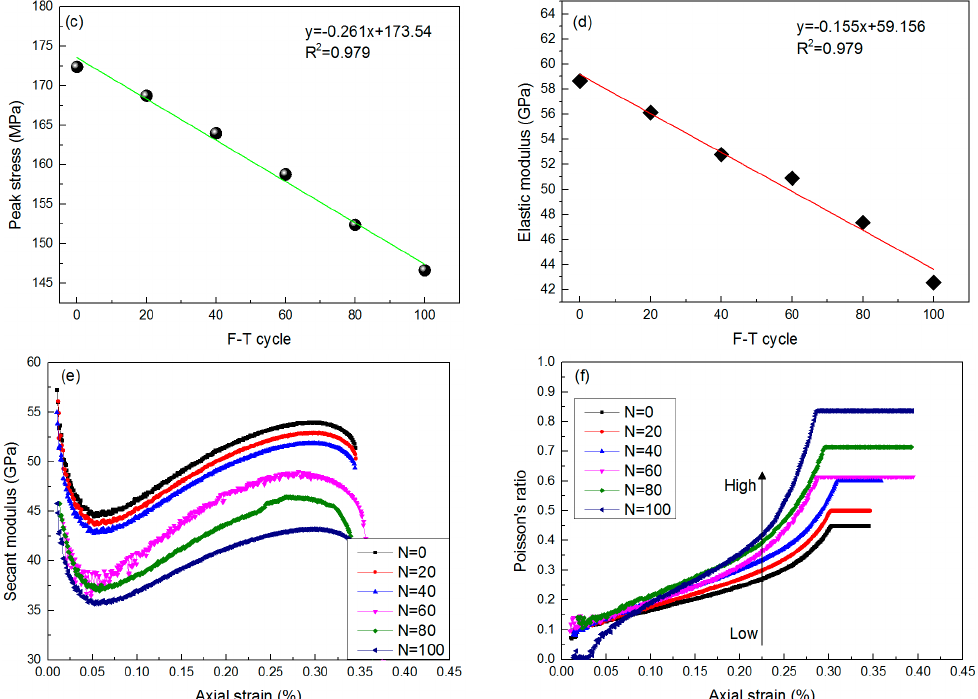
Figure 9. Strength and deformation characteristics of granite samples subjected to di ff erent F–T cycles. ( a ) The axial and lateral stress–strain curves for the samples tested with 0, 20, 40, 60, 80 or 100 F–T cycles; ( b ) the volumetric stress–strain curves for rock samples subjected to di ff erent F–T cycles. ( c ) The relationship between uniaxial compression strength (UCS) and F–T cycles; ( d ) the relationship between the elastic modulus and F–T cycles; ( e ) plots of secant modulus against axial strain for the samples tested. ( f ) Plots of the Possion’s ratio against F–T cycles for the samples tested.